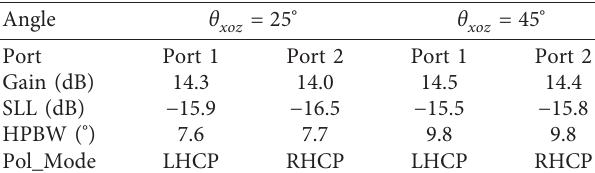
Table 3: Radiation performance of the RPA